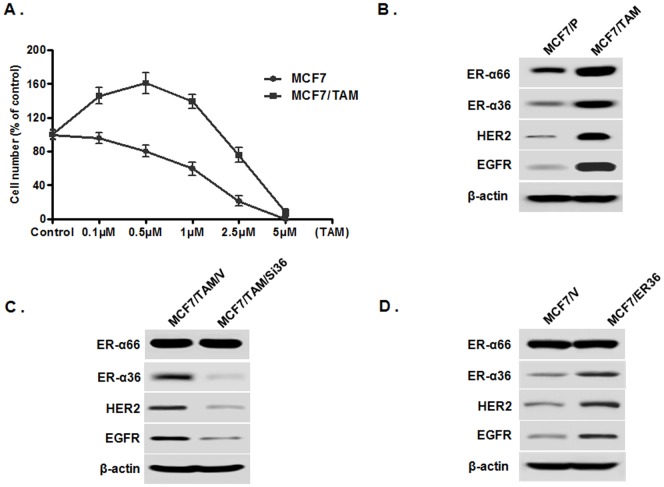
Tamoxifen resistant ER-positive breast cancer MCF7 cells express ER-α36-EGFR/HER2 regulatory loops.A. ER-positive breast cancer MCF7 cells and tamoxifen resistant MCF7 cells (MCF7/TAM) cells were treated with indicated concentrations of TAM for seven days and survived cells were counted. Each point represents the means of three experiments; bars, SE. B. Western blot analysis of the expression levels of ER-α66, ER-α36, EGFR and HER2 in parental MCF7 (MCF7/P) and MCF7/TAM cells. C. Expression of ER-α66, ER-α36, EGFR and HER2 in MCF7/TAM cells transfected with the empty expression vector (MCF7/TAM/V) and MCF7/TAM cells with knocked-down levels of ER-α36 expression (MCF7/TAM/Si36). D. Expression of ER-α66, ER-α36, EGFR and HER2 in MCF7 cells transfected with the empty expression vector (MCF7/V) and MCF7 cells with forced expression of ER-α36 recombinant DNA (MCF7/ER36).